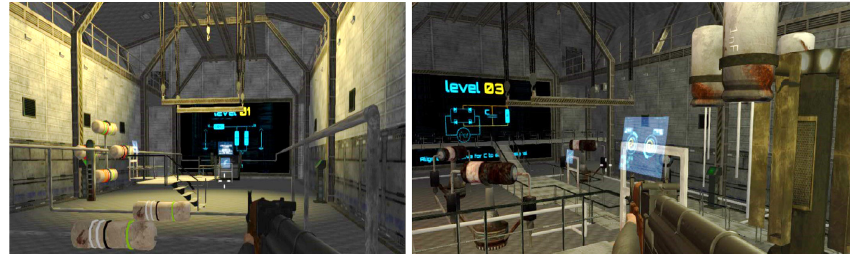
Fig. 9. First person perspective and diode circuit